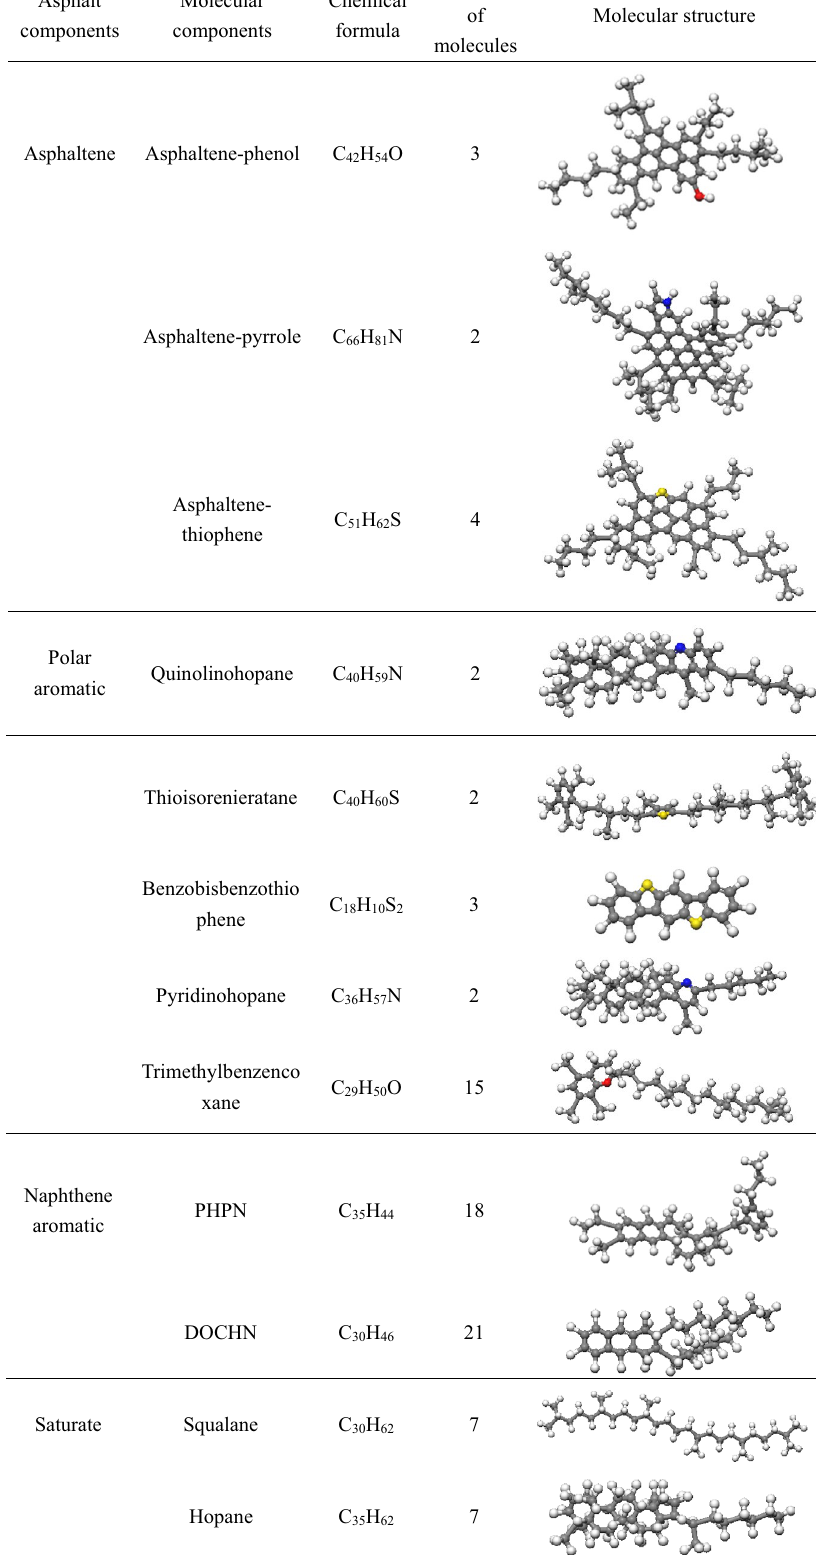
Table 1. Molecular composition of the virgin